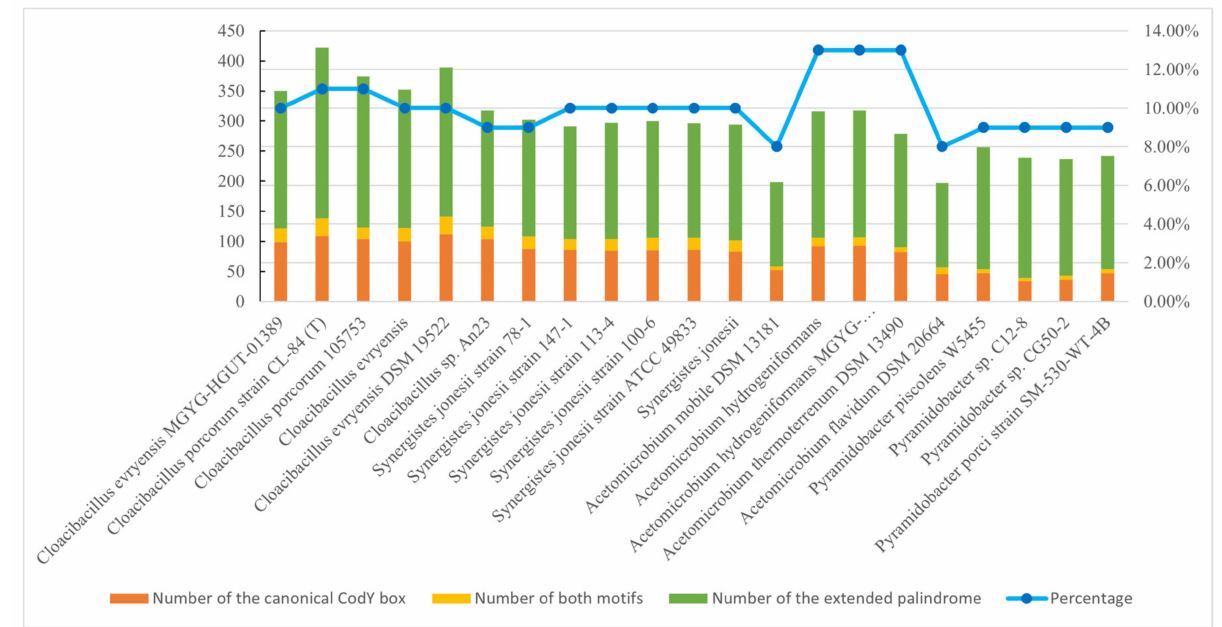
Figure 5. The distribution of genes regulated by the CodY-like protein in the available genomes of the phylum Synergistetes. The number of loci that harbor the canonical CodY box, the newly defined extended palindromic sequence, and both motifs in the promoter regions are shown in orange, green and light orange, respectively. The percentages of total targets in the genomes are